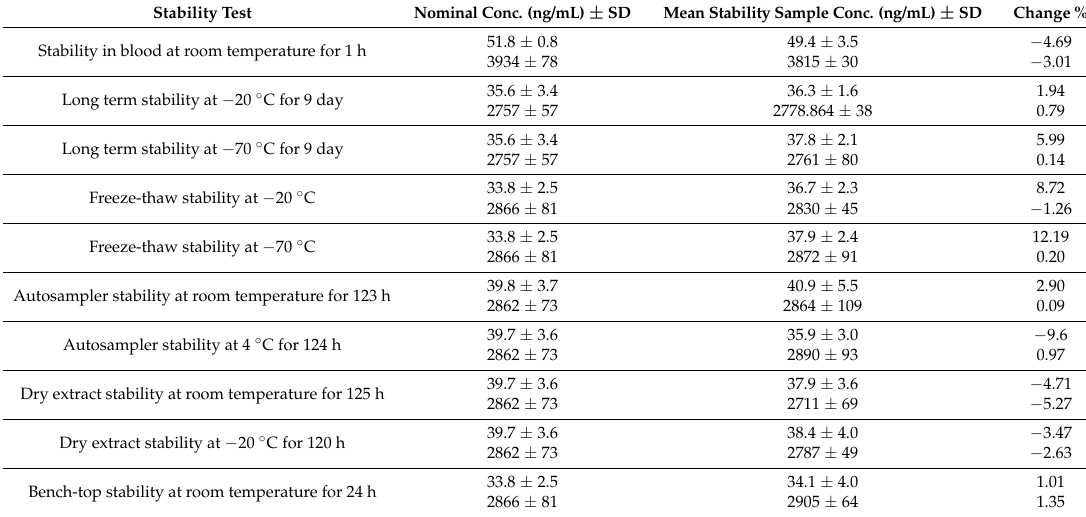
Table 5. Stability of folic acid QCL and QCH samples in plasma ( n =